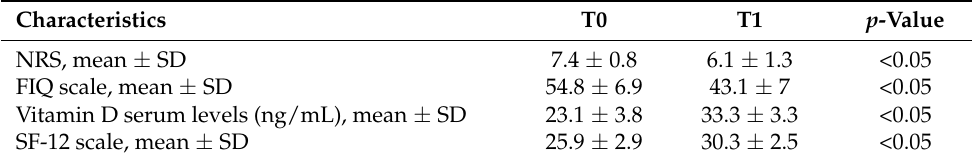
Table 4. Effects of vitamin D supplementation at 3 months in group B.